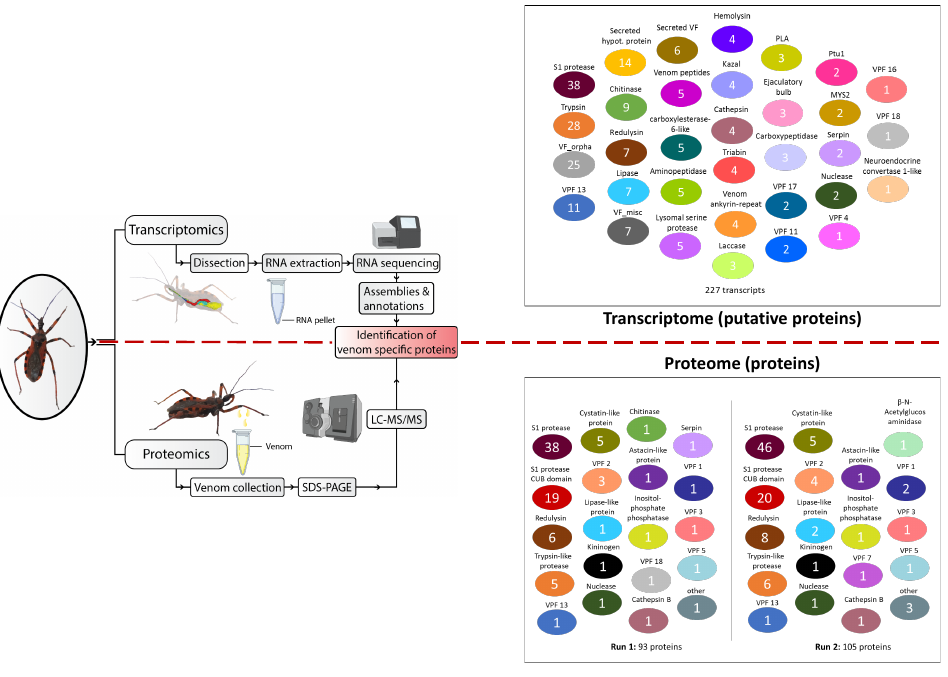
Figure 8. Rhynocoris iracundus transcriptome and proteome analysis workflow and identified venom protein families. In the venom gland transcriptome, 227 transcripts belonging to venom protein families were identified ( top right ), while venom proteome analysis resulted in the identification of 93 proteins and 105 proteins for each run, respectively ( bottom right ). Putative proteins and proteins belonging to the same protein family are indicated with identical